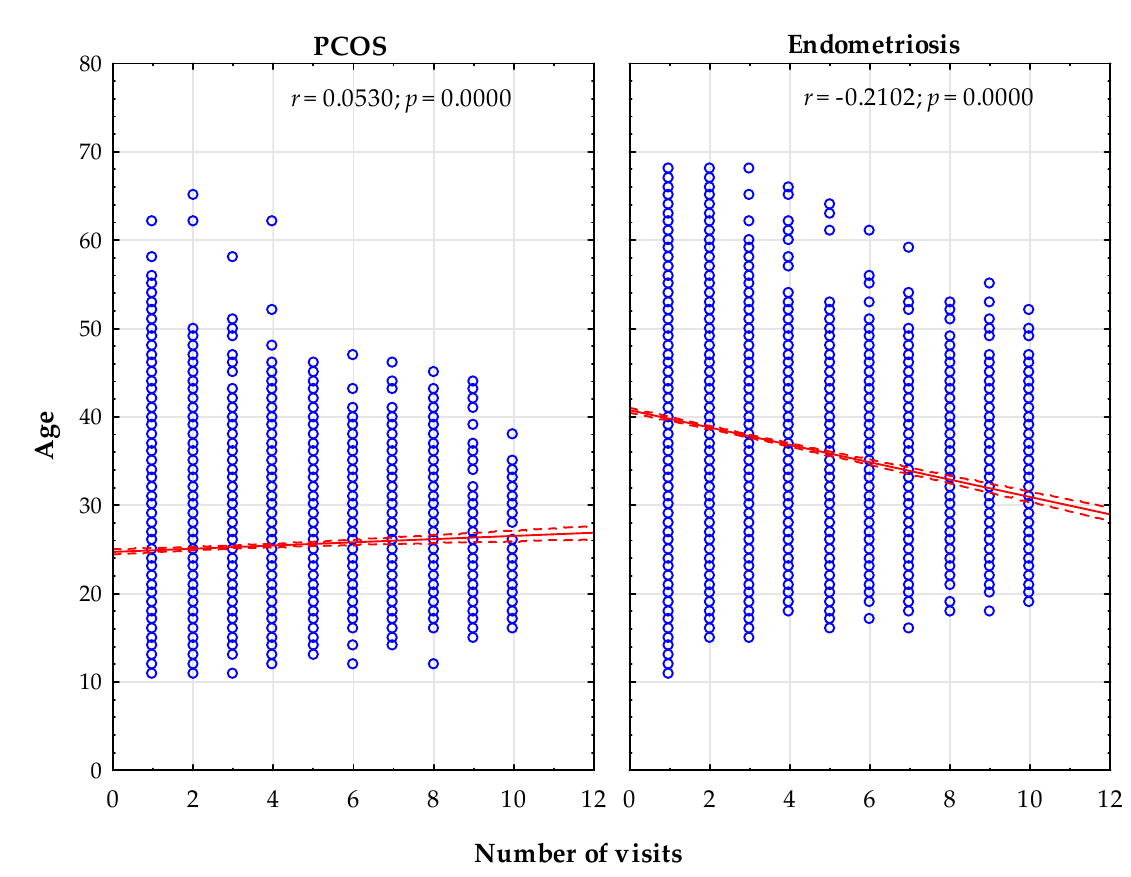
Figure 1. Correlation between the number of visits and the age of the women surveyed. Table 2. Visits of women with PCOS to AOS in relation to age and macroregion of residence.